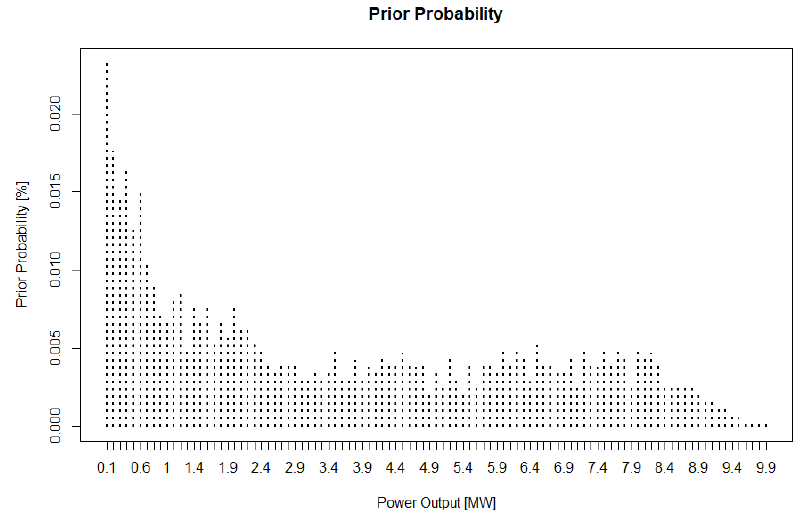
Figure 7. Prior probability used in the simulation.